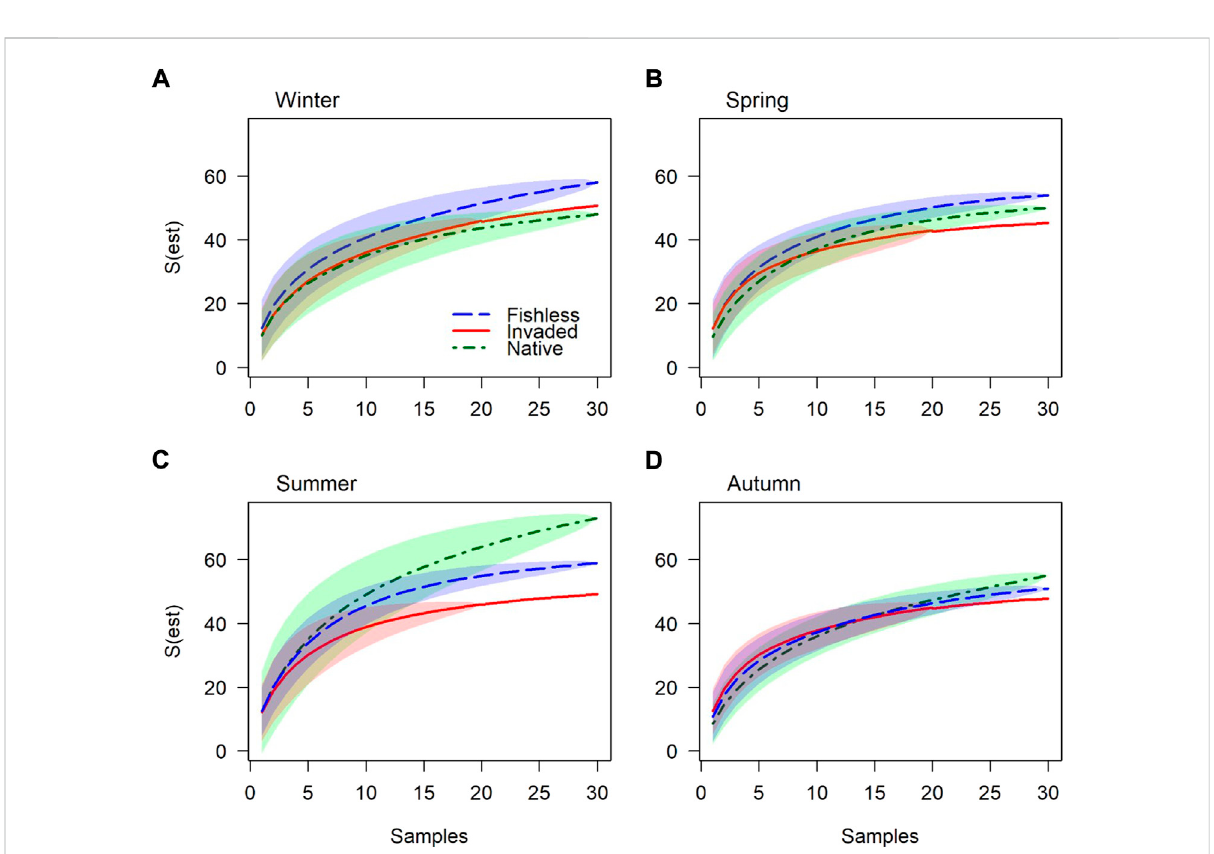
FIGURE 4 Macroinvertebrate species richness accumulation curves for river reaches without fi sh, invaded by trout, and inhabited by native fi sh, for (A) . Winter, (B) .Spring, (C) .Summerand (D) .Autumn.Standarddeviationisindicatedbyshadedareas.Speciesrichnessbetween20and30samplesinthe invaded reach were extrapolated from the Lomolino